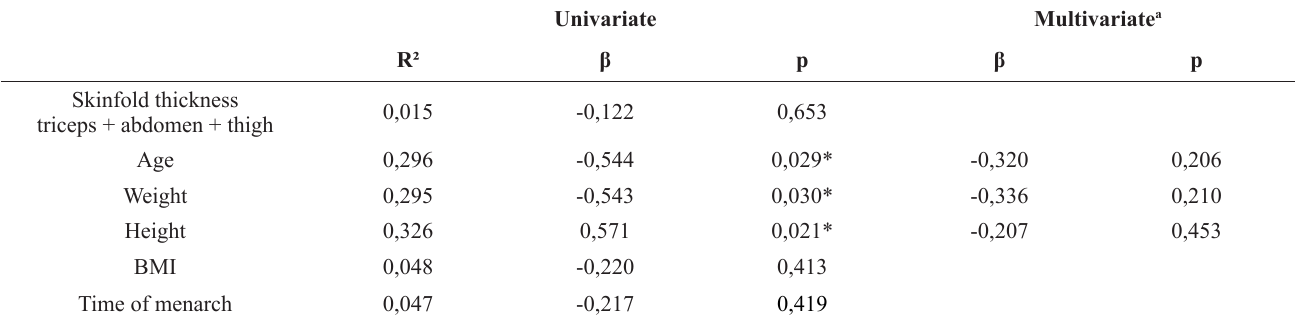
Legend: BMI - Body mass index. Table 3 - Univariate and multivariate linear regression in the post-menarche group with the motor performance (time trial) as a dependent variable.